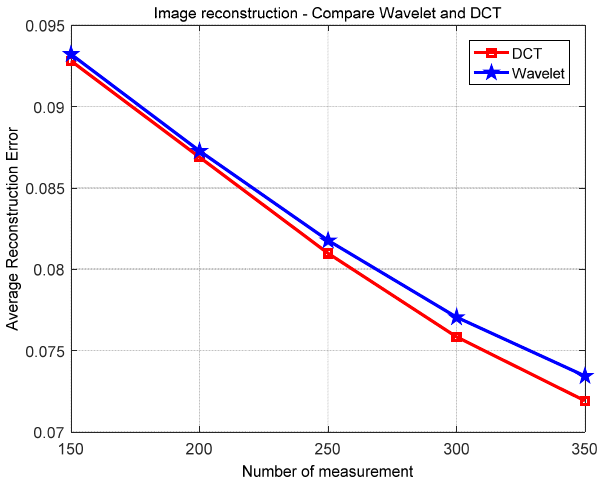
Figure 6. The image is reconstruct by the CS recovery algorithm L1 using both DCT and Wavelet basics